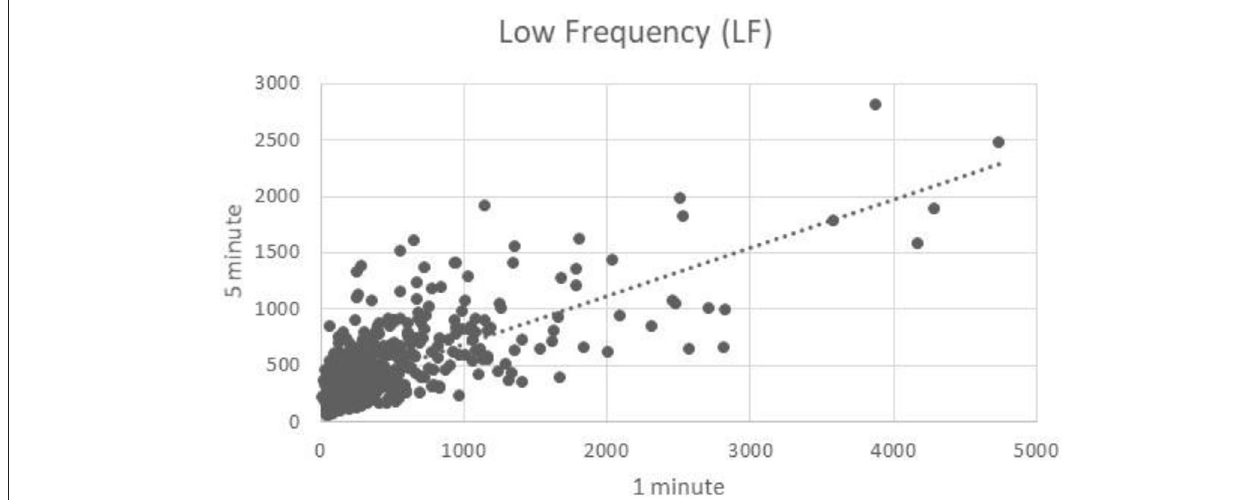
FIGURE 3 | Low frequency component correlation.